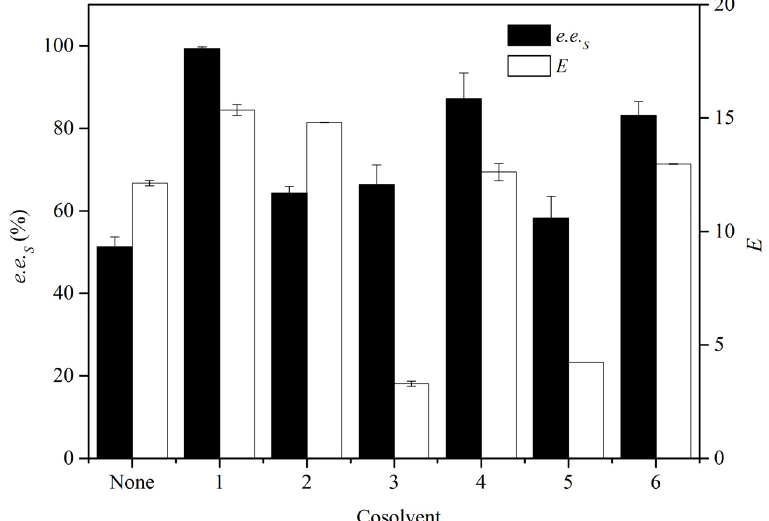
Figure 2. Effects of co-solvents on the resolution of rac -EPG by G. geotrichum ZJUTZQ200. Reaction conditions: 1.0 g wet mycelium, 0.01 mL rac -EPG, 10 mL KPB (100 mM, pH 7.0), 30 °C, 200 rpm, 6